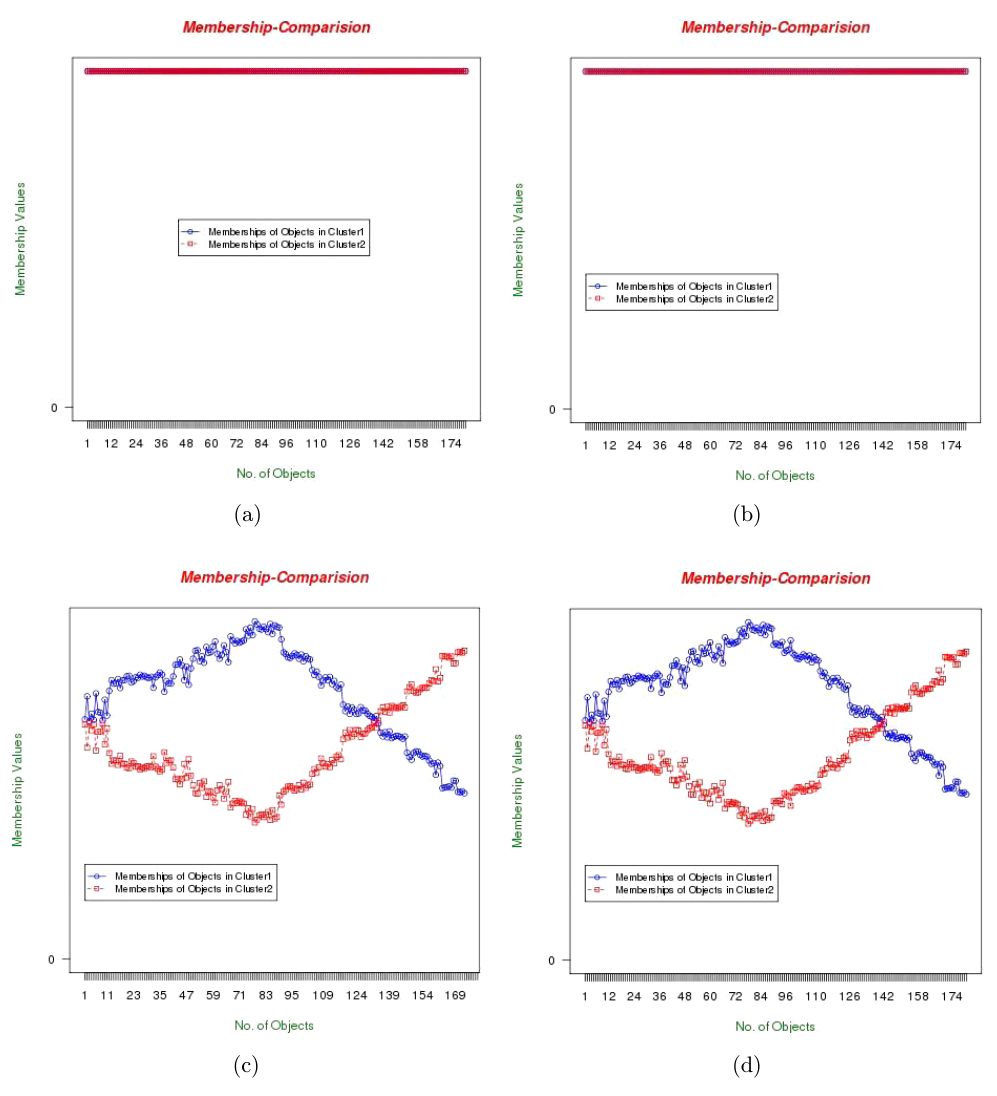
Fig. 12. Comparison of membership (a) by GKFCM (b) by KFCM (c) by KEFCM wd and (d) by KFCM nt .